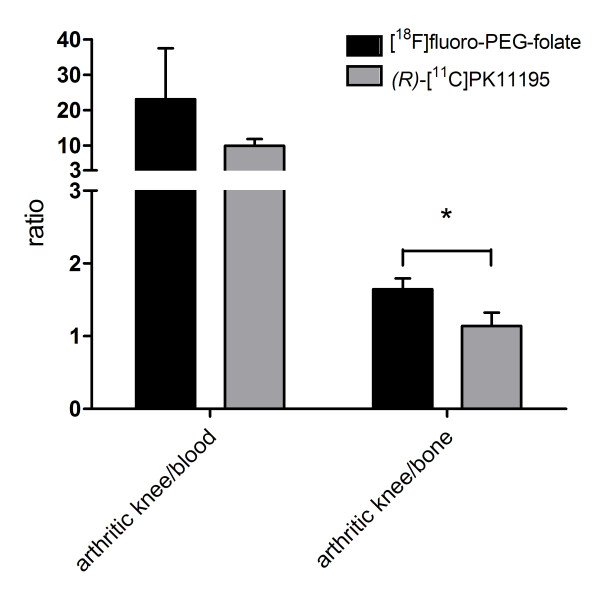
Target-to-background ratios of [18F]fluoro-PEG-folate. Arthritic knee-to-bone and arthritic knee-to-blood ratios of [18F]fluoro-PEG-folate (black bars) and (R)-[11C]PK11195 (grey bars) obtained from ex vivo tissue distribution studies. Results are presented as mean ± SD of four rats for [18F]fluoro-PEG-folate and five rats for (R)-[11C]PK11195. *= P <0.05